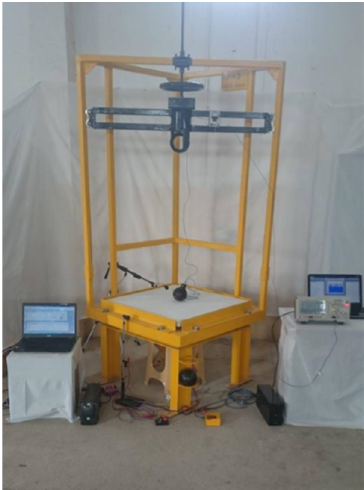
Figure 5: Test apparatus for impact with